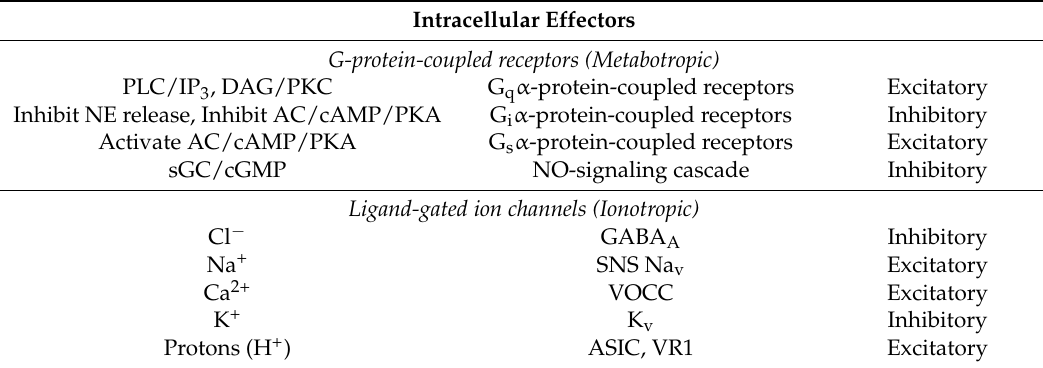
Table 2. The pain-mediated intracellular effectors and their signaling mechanism